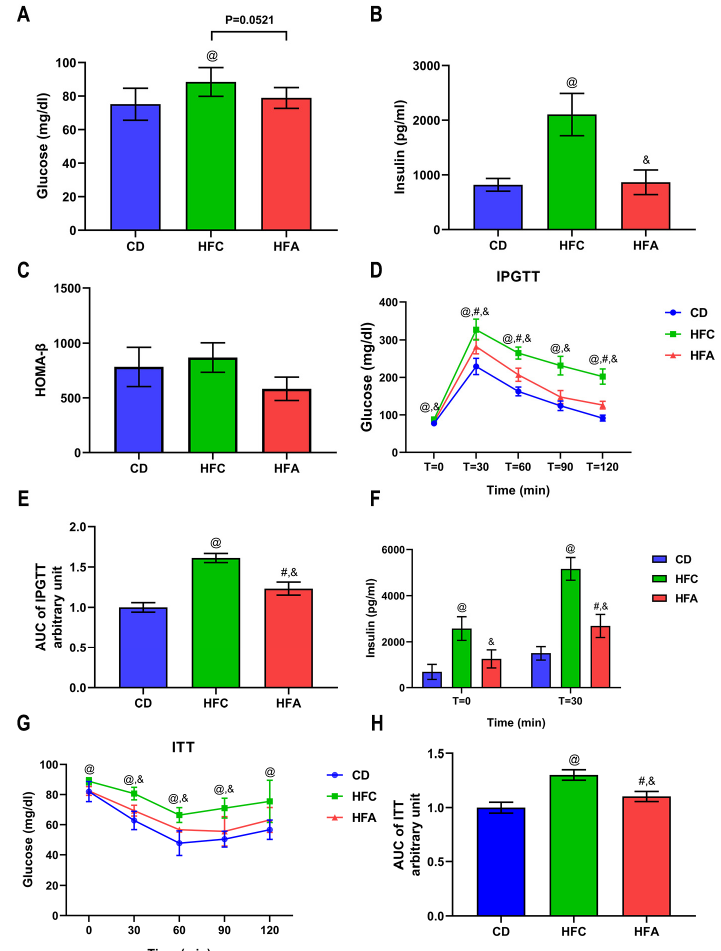
Figure 2. Effects of D -allulose supplementation for 4 weeks on glucose metabolism. ( A ) Fasting blood glucose level, ( B ) fasting plasma insulin level, ( C ) the value of HOMA- β , ( D ) blood glucose levels during IPGTT, ( E ) area under the curve during IPGTT, ( F ) insulin level at T = 0 and T = 30 min during IPGTT, ( G ) blood glucose levels during ITT, and ( H ) area under the curve during ITT. Results are expressed as mean ± SD. @: CD vs. HFC, #: CD vs. HFA, &: HFC vs. HFA, p < 0.05, n = 6 per group; and ns, no significant difference. Differences were determined using two-way ANOVA assessed for repeated measures ( D , G ) and one-way ANOVA ( A – C , E , F , H ). CD: chow diet, HFA: HFD + D -allulose, HFC: HFD + cellulose, HFD: high-fat diet, HOMA- β : the homeostasis model assessment of β -cell function, IPGTT: intraperitoneal glucose tolerance test, and ITT: insulin tolerance